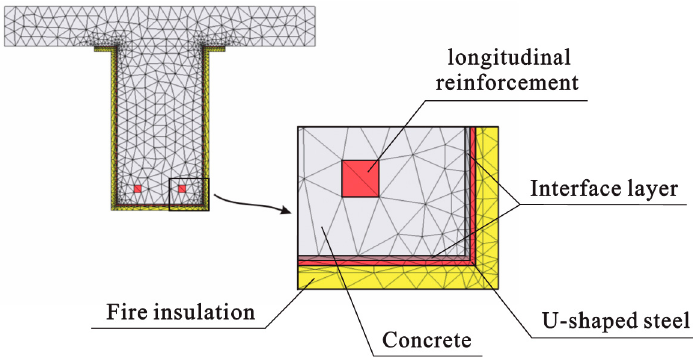
Figure 21. Finite-element model of the beam for thermal analysis.